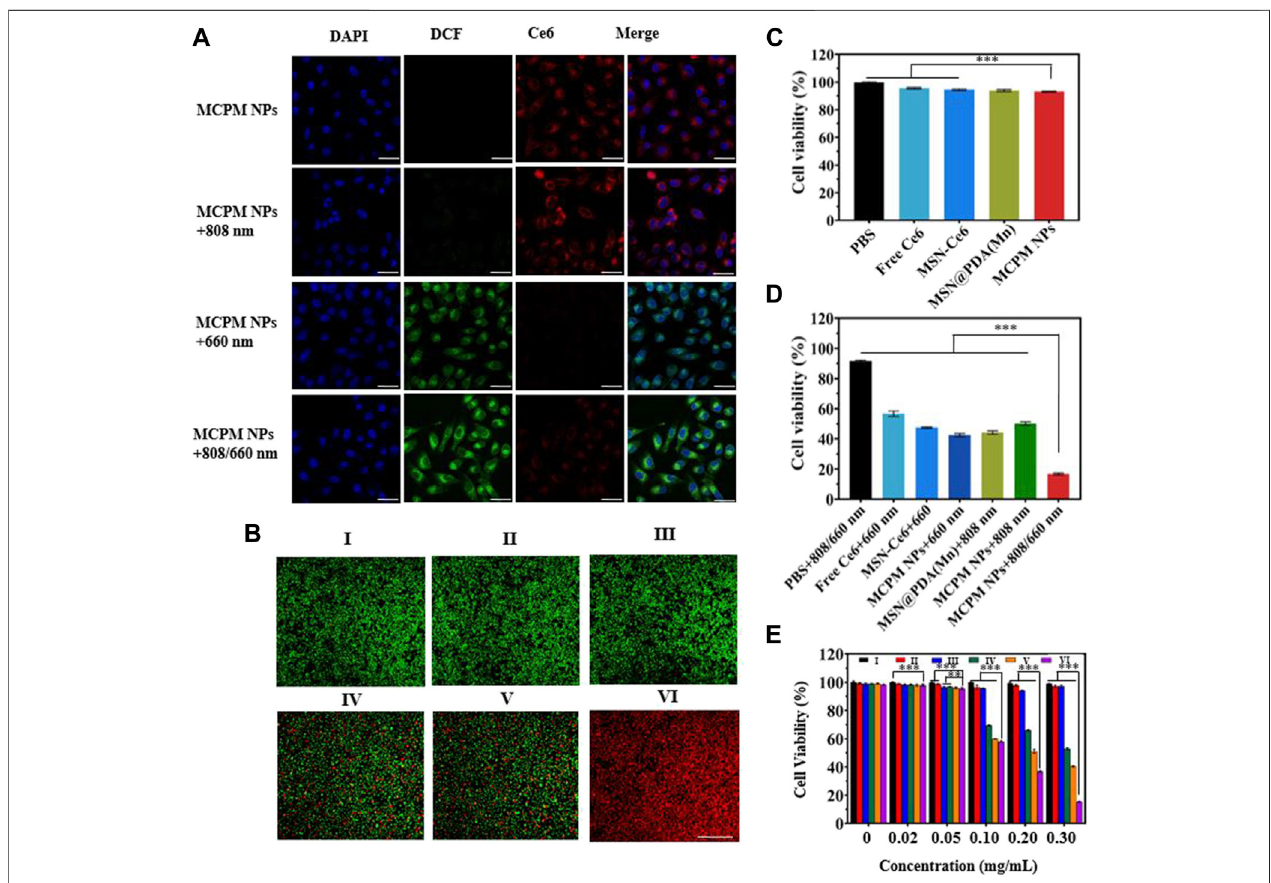
FIGURE 6 | In vitro performance of MCPM NPs tested in MDA-MB-231 cells. (A) Detection of singlet oxygen in MDA-MB-231 cells undergoing treatment with MCPM NPs under various modes of laser irradiation with DCFH-DA assay, scale bar (cid:2) 20 μ m. (B) Staining pro fi les of viable and dead MDA-MB-231 cells treated with MCPMNP-basedPTT/PDT. (C) ViabilityofMDA-MB-231cellstreatedwithNPs. (D) ViabilityofMDA-MB-231cellstreatedwithNPsandlaserirradiation. (E) Cellviability at different concentrations of NP-based PTT/PDT. The irradiations are conducted at 808 nm (1.0 W cm − 2 , 10 min) and 660 nm (100 mW cm − 2 , 10 min) for the above experiments. Dataareshownasmean ± S.D.( n (cid:2) 6),** p < 0.01,*** p < 0.001.(Groups I-VIaredesignatedasPBS,MCPMNPs,PBS+808/660 nm laser,MCPM NPs + 808 nm laser, MCPM NPs + 660 nm laser, and MCPM NPs + 808/660 nm laser groups, respectively).